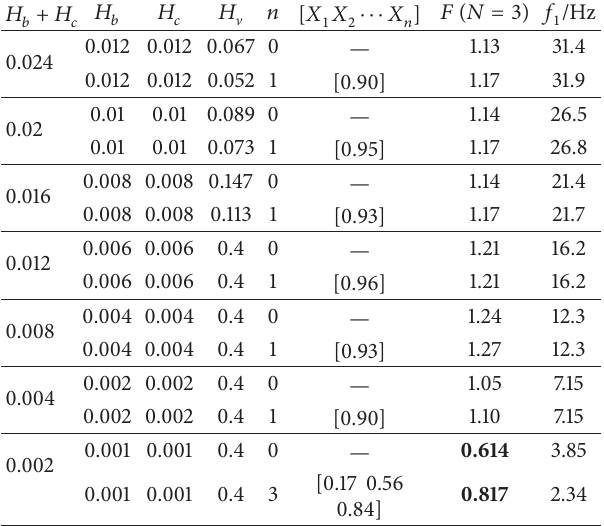
Table 6: Optimization results for symmetric CLD